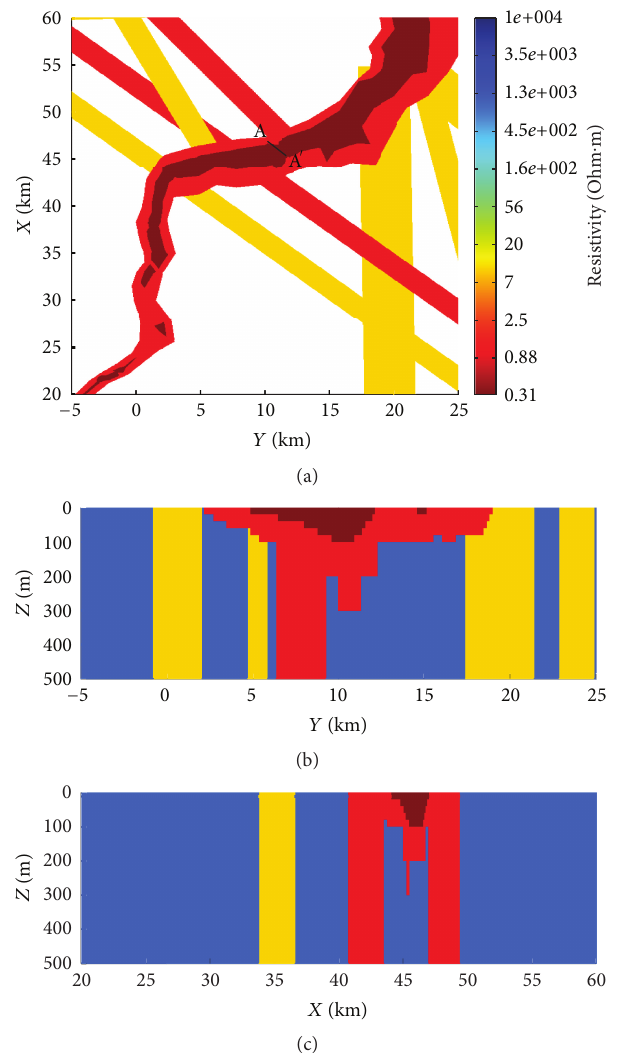
Figure 7: Geoelectric model resulting from trial and error, (a) XY section at 𝑧 = 0 m, (b) YZ section at 𝑥 = 45.36 km, and (c) XZ section at 𝑦 = 11.19 km. The line AA 󸀠 represents the profile of observations corresponding to the sites from 5 to 1 in Figure